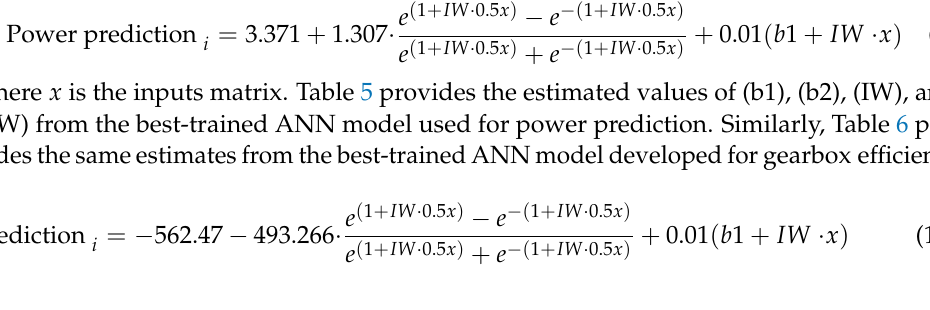
Table 5. Weights and biases of the best-trained ANN power prediction model.